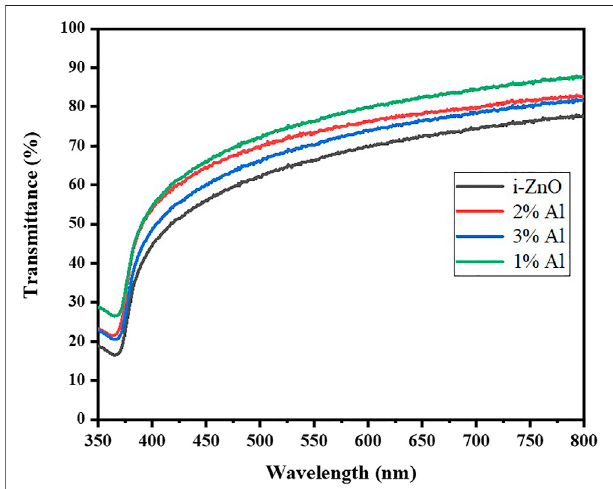
FIGURE 4 | Optical transmittance spectra of ZnO and Al doped ZnO thin fi lms.